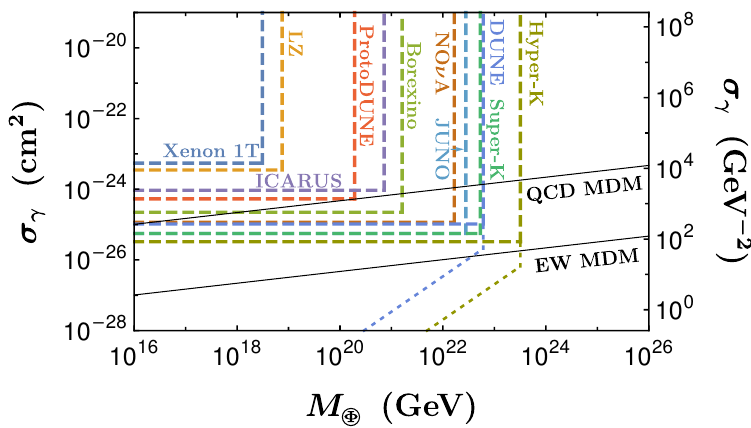
Figure 7 . Sensitivity of Xenon 1T (blue) [28], LZ (orange) [29], ProtoDUNE (red) [35], ICARUS (purple) [38], Borexino (green) [39], NO (cid:23) A (brown) [34], JUNO (light blue) [40], Super-Kamiokande (teal) [36], DUNE (dark blue) [43], and Hyper-Kamiokande (dark green) [32] to radiative capture of nuclei by MDM. The experiments are listed in order of increasing mass sensitivity. The dashed lines indicate the sensitivity if at least 5 radiative capture events are required for each MDM passage through the detector. A running time of 10 years is assumed for Borexino, Super-Kamiokande, DUNE, and Hyper-Kamiokande, 5 years is assumed for ICARUS and NO (cid:23) A and one year at the direct detection experiments and ProtoDUNE. The dotted lines for DUNE and Hyper-Kamiokande indicate the region in which at least one radiative capture event is expected over the whole running time. The black line indicates the estimated radiative capture cross section for QCD and EW density